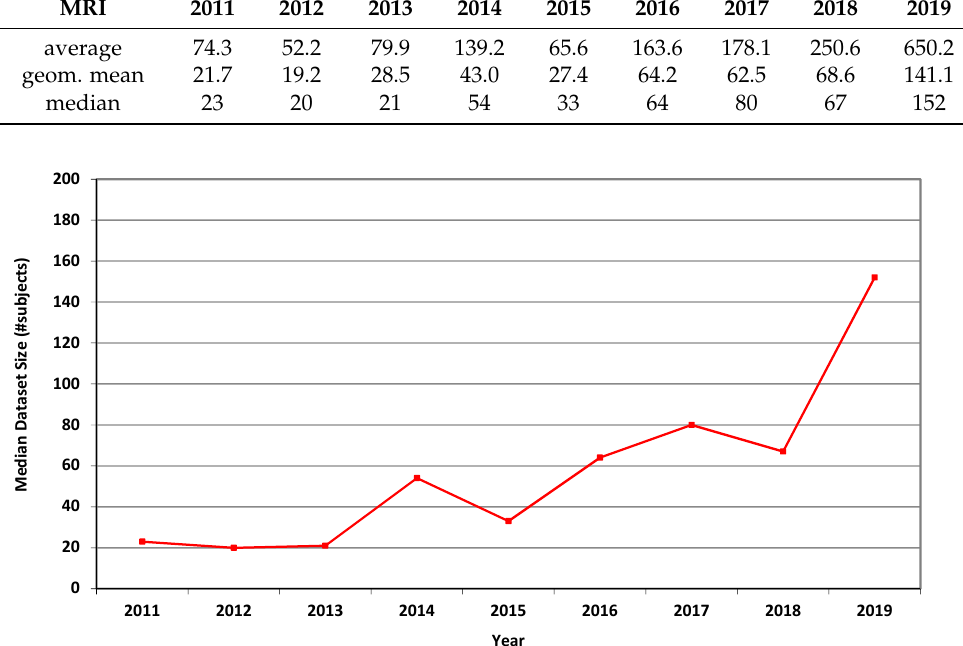
Table 4. Average, geometric mean and median CT dataset sizes (number of subjects) used in MIC- CAI articles in each of the years 2011–2019.